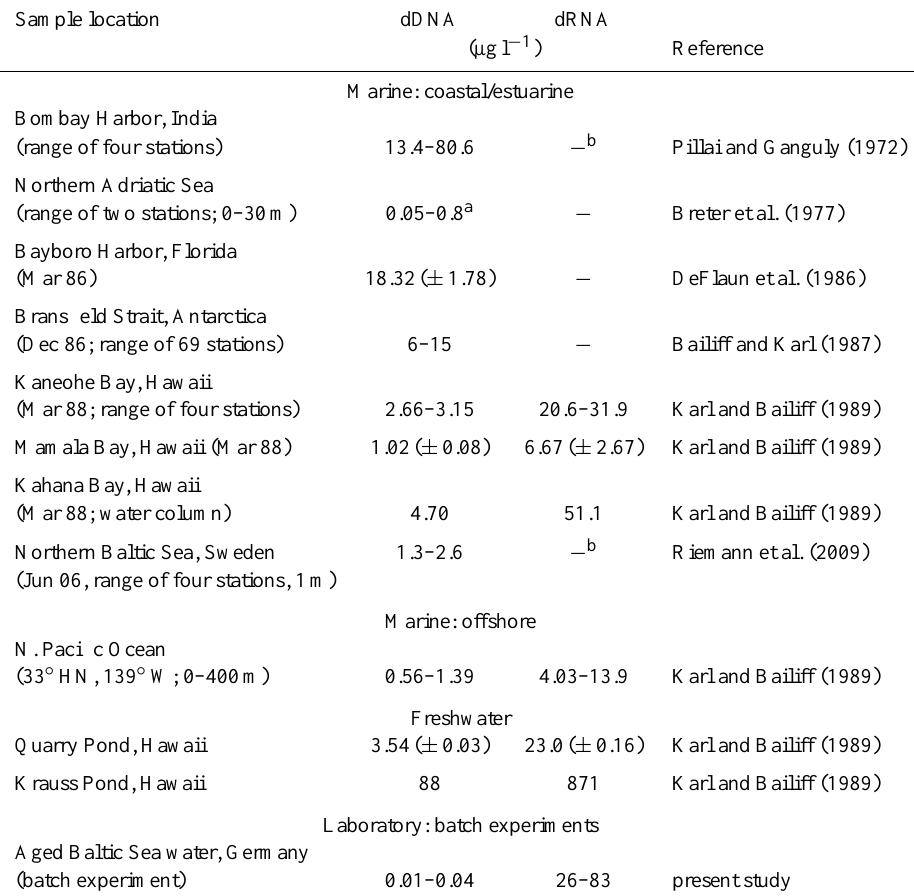
Table 4. dDNA and dRNA values for marine and freshwater stations adapt from Karl and Bailiff